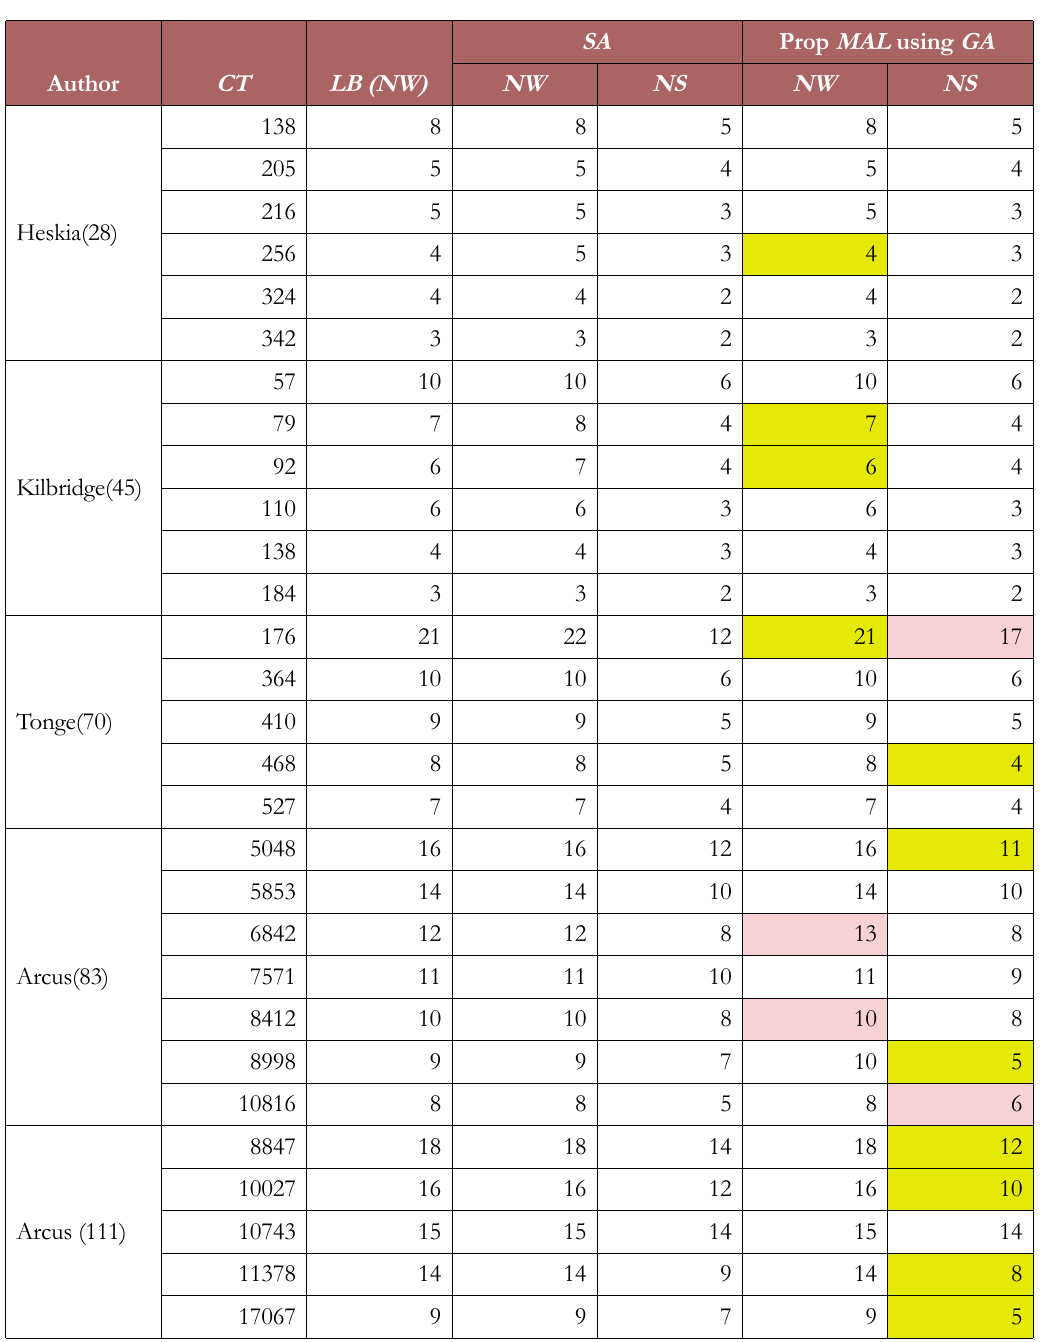
Yellow color: means better solution saving in number of workers or number of stations for the proposed MALB model compared to SA . Pink color: means worse solution increasing in number of workers or number of stations for the proposed MALB model compared to SA . Table 3. Results of proposed MAL model compared to SA model